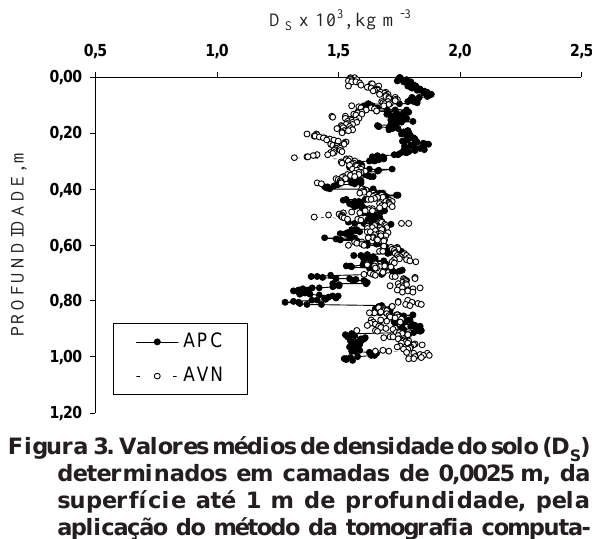
Figura 3. Valores médios de densidade do solo (D determinados em camadas de 0,0025 m, da superfície até 1 m de profundidade, pela aplicação do método da tomografia computa- dorizada e para as duas áreas avaliadas, área sob vegetação nativa (AVN) e área sob cultivo constante e irrigada por pivô central